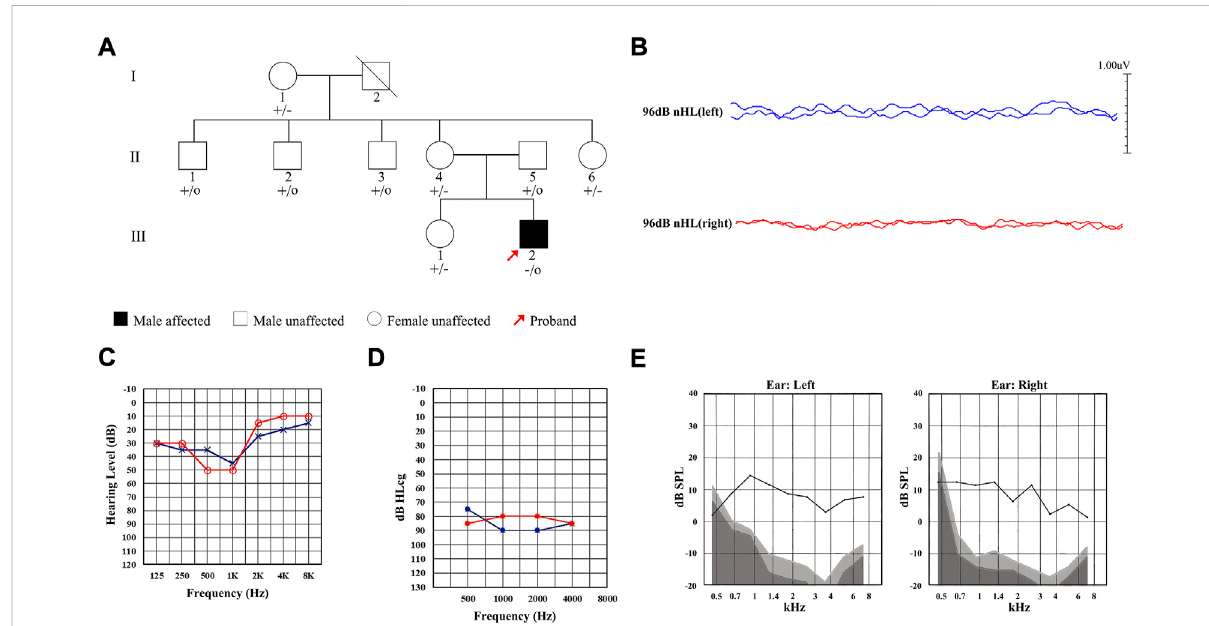
FIGURE 1 Pedigree andclinicalcharacteristicsoftheChinesefamily diagnosedwithauditoryneuropathy(AN). (A) PedigreeoftheChinesefamilywithAN. Individuals harboring hemizygous ( – /o) or heterozygous (+/ – ) AIFM1 (c.1367A > G) mutation and WT (+/+) are indicated. The red arrow denotes the proband. The square indicates a male and the circle indicates a female. The hearing-impaired individual is indicated by a blackened square. (B) ABR thresholds of the proband. Red and blue lines represent the right and left ears, respectively. (C) PTA test of the proband. Red and blue lines representtherightandleftears,respectively. (D) ASSRthresholdsoftheproband.Redandbluelinesrepresenttherightandleftears,respectively. (E) DPOAE test results of the proband. Gray area indicates level of noise and the black line indicates the level of